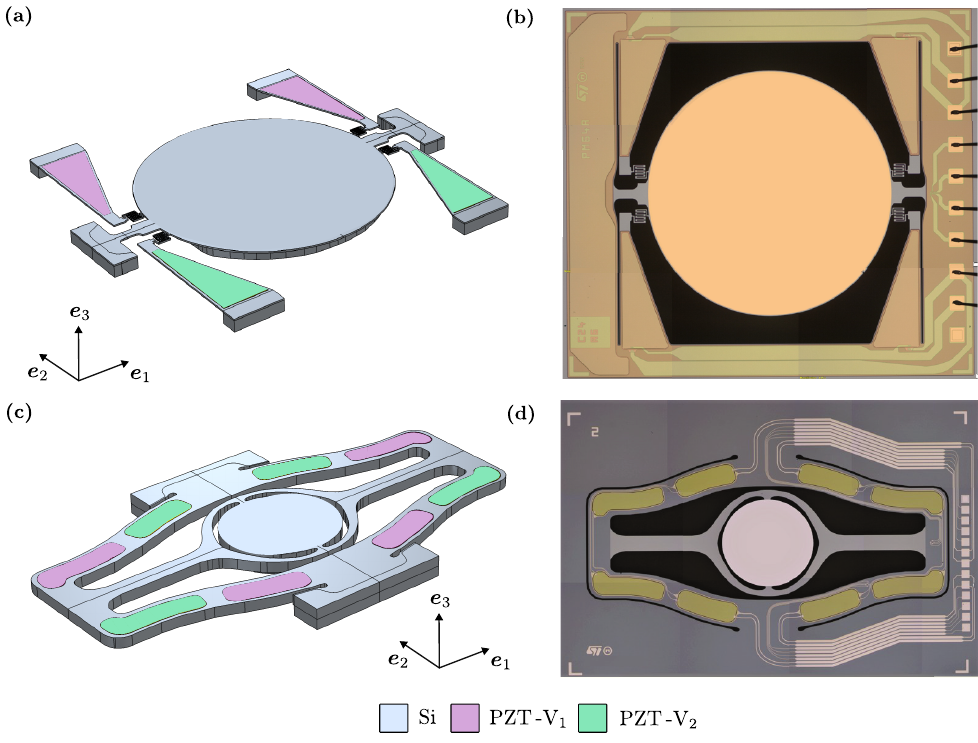
Figure 1. Geometries of Micromirror 1 ( a ) and Micromirror 2 ( c ); optical microscope pictures of the tested devices for Micromirror 1 ( b ) and Micromirror 2 ( d ). Grey colour is used for silicon. Pink and light green colours are used to highlight the PZT actuation patches and denote different actuation biases. The reflective surfaces have radii of 1500 µ m and 900 µ m,